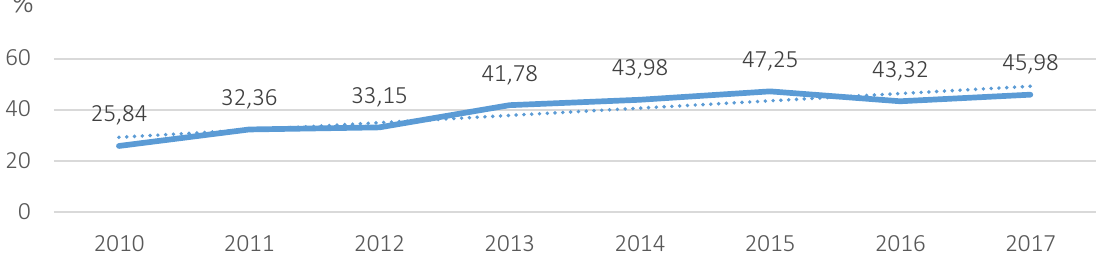
Figure 1. Changes in the share of life insurance from ICF in the structure of gross written premium in Section I in Poland in